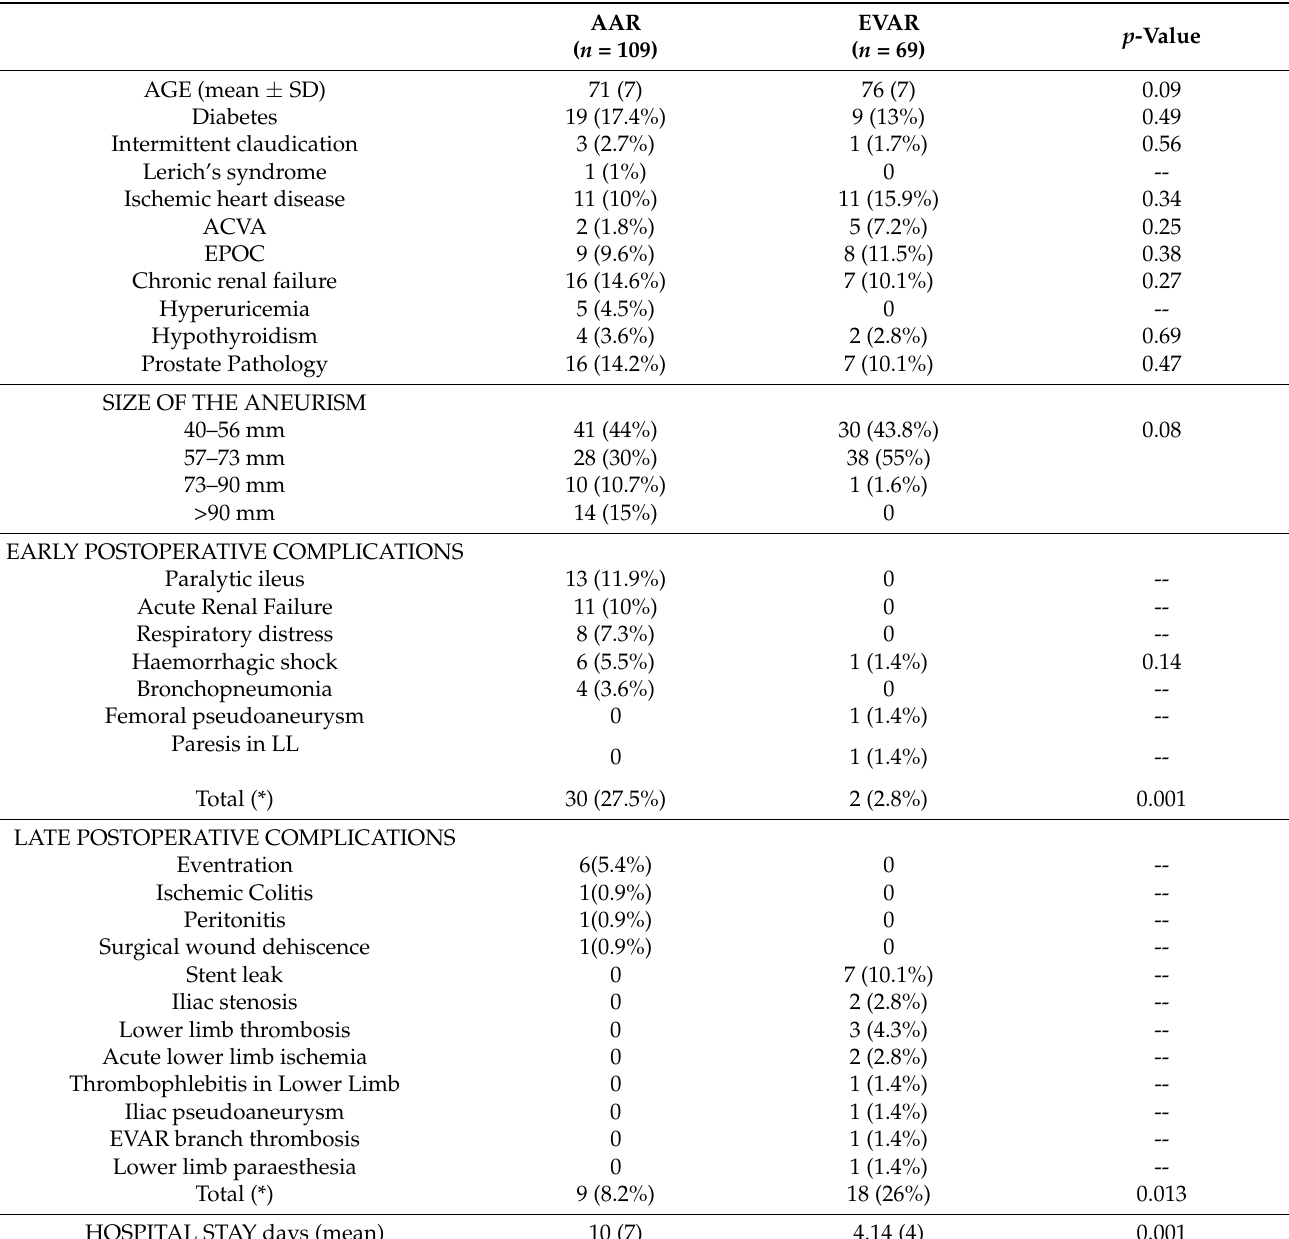
Table 1. Characteristics and Complications of Patients Operated for